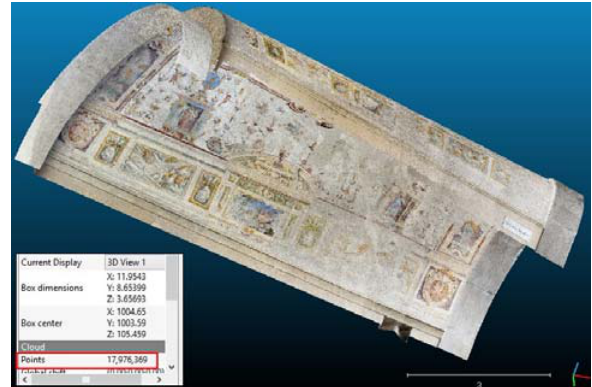
Figure 16 – Scanned Point Cloud which is displayed segmented in a similar size (17.9M) to the photogrammetric point cloud (18.3M), in order to be